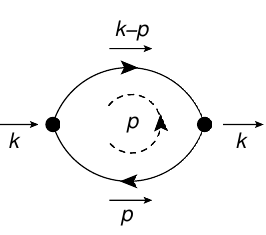
ˆ T µν ( k ) ˆ T ρσ ( k ) correlation function for h − i